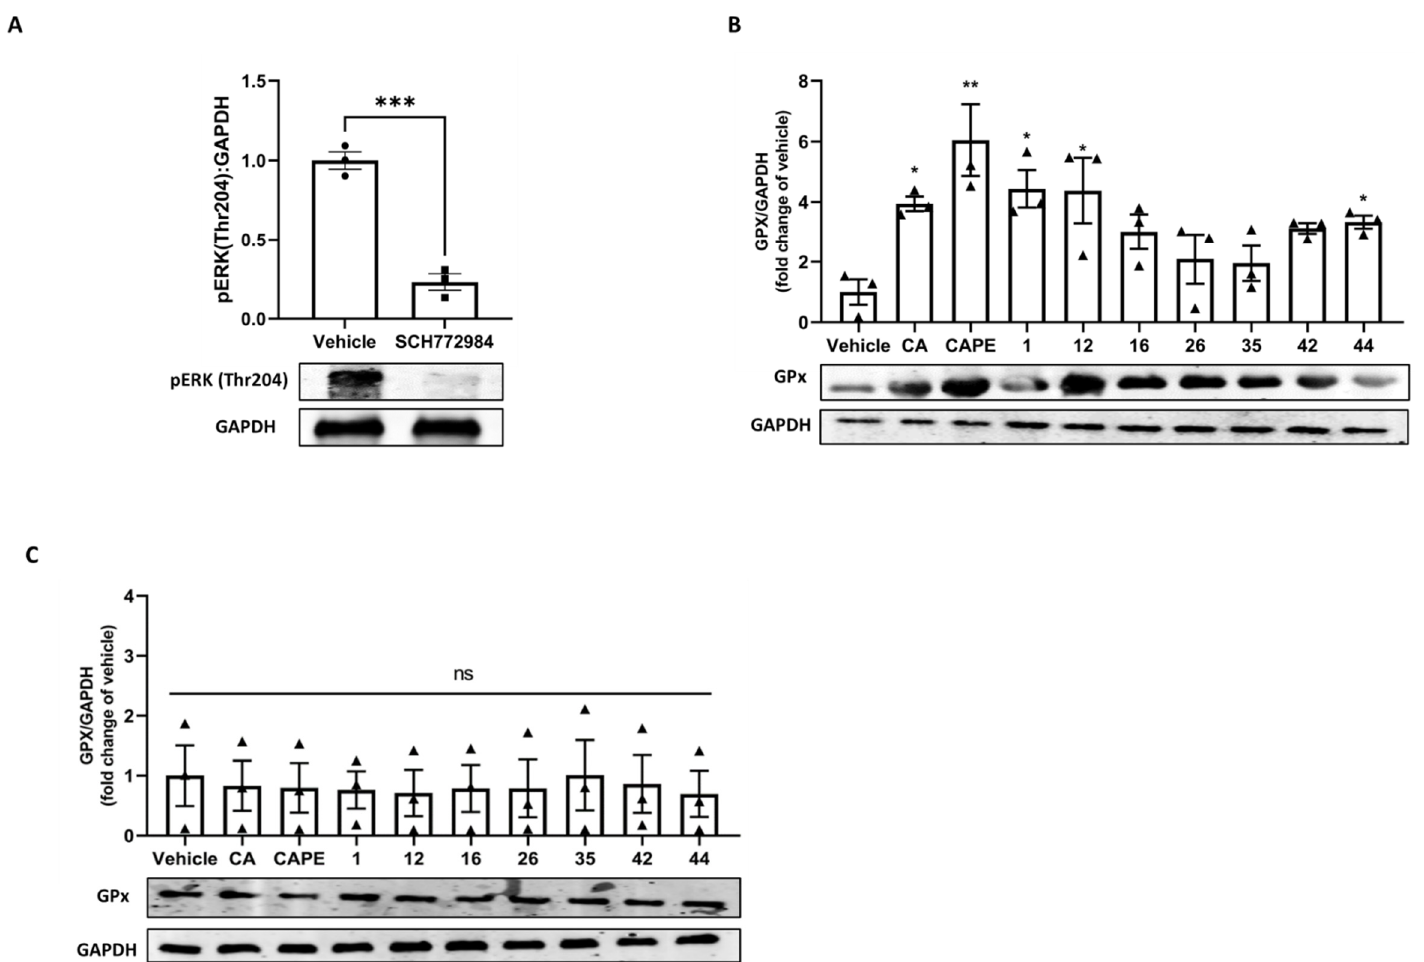
Figure 7. The impact of Caffeic acid and CAPE analogs on key antioxidant parameter GPx is dependent on ERK phosphorylation. ( A ) ERK inhibitor SCH772984 (1 µ Μ ) was used to lower ERK phosphorylation levels in 293T cells (immunoprecipitated). Next, 293T cells were pre-treated with 10 µ Μ of the selected compounds for 24 h, ( B ) without and ( C ) with ERK inhibitor SCH772984 (1 µ Μ ), and then the changes in selected biomarker, GPx, was observed using western blot. * p < 0.05, ** p < 0.01, *** p < 0.001, ns: non-significant.